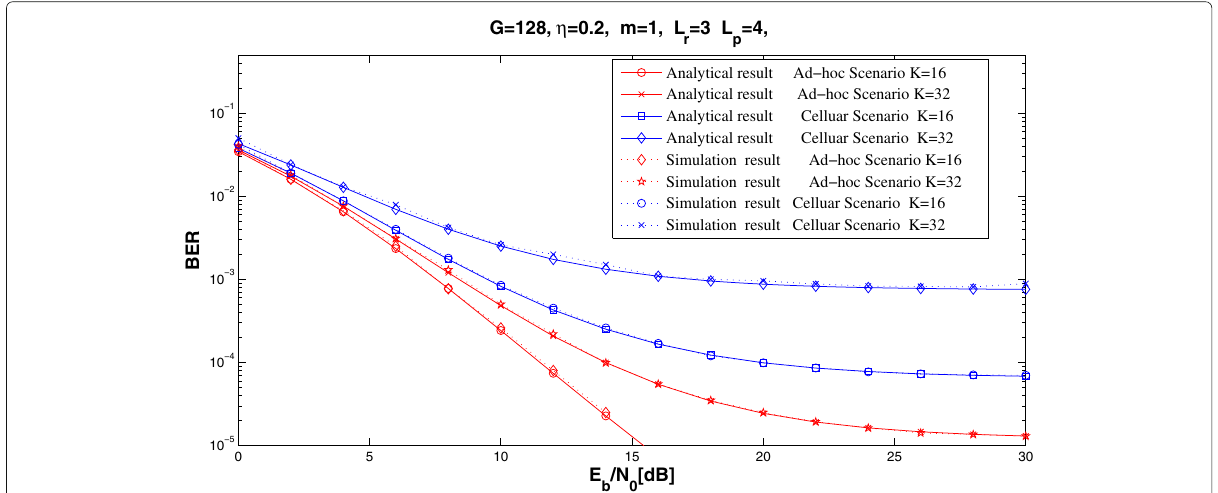
Fig. 6 BER vs E b / N 0 performance in the context of the ad hoc and cellular